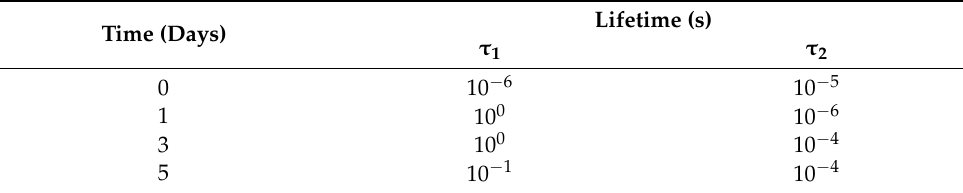
Table 4. Time components τ 1 and τ 2 obtained from EIS data for sample TN with cells growing on its surface.